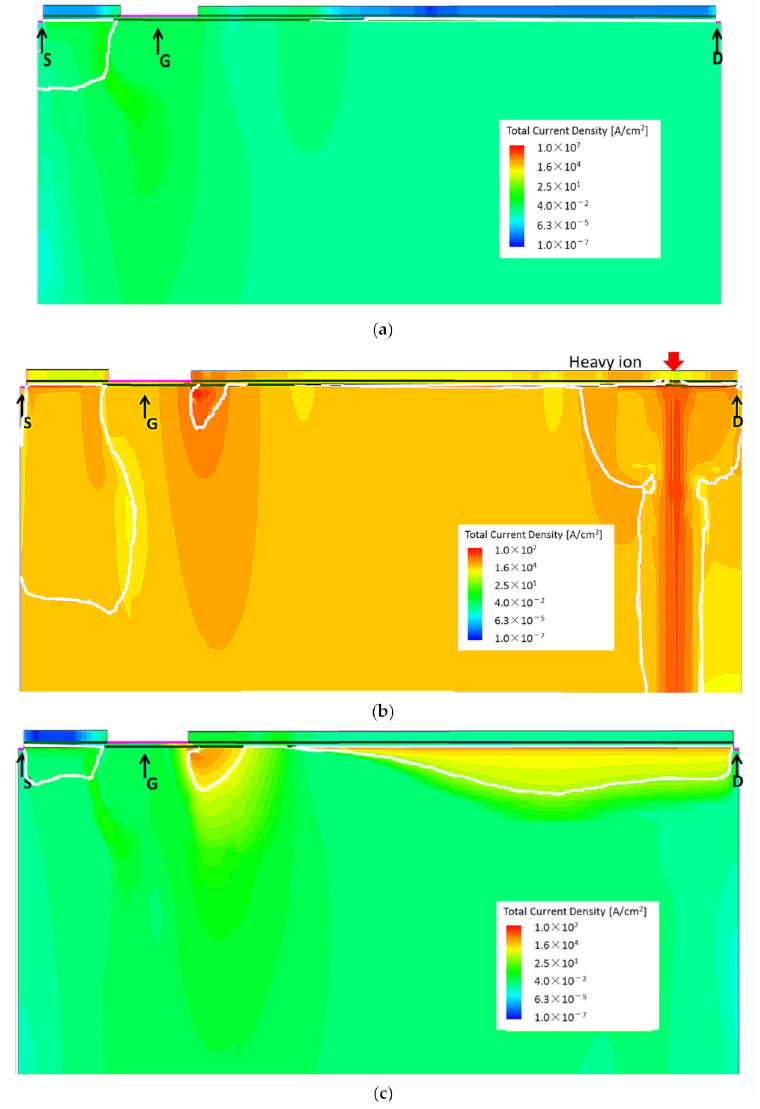
Figure 10. The cross-sections of the total current density with time after heavy-ion striking at P8: ( a ) before heavy-ion striking, ( b ) 0.05 ns after heavy-ion striking, and ( c ) 50 ns after heavy-ion striking. The white line represented the depletion